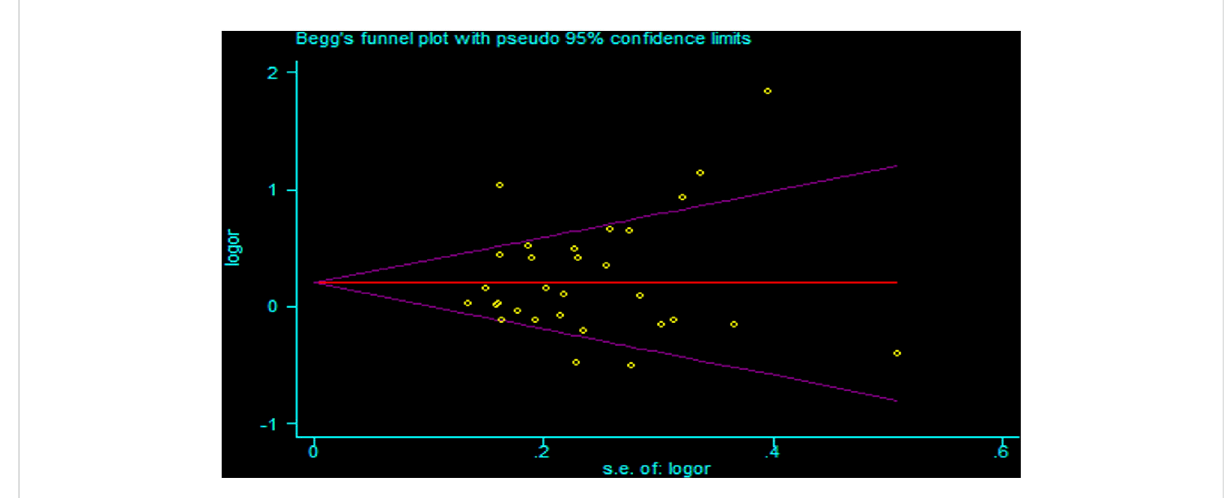
FIGURE 4 Funnel plots for publication bias of H19 rs2839698 polymorphism in the overall population (allele model: A vs